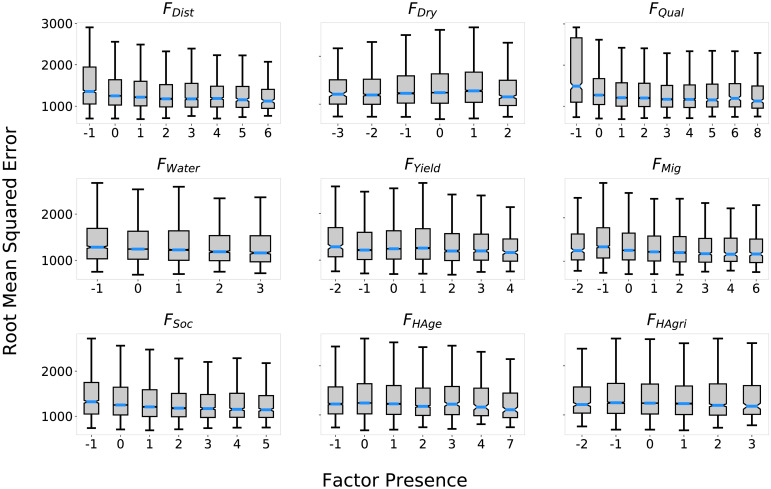
RMSE vs factor presence under SAll.RMSE distributions by factor presence produced by evolutionary model discovery of the farm selection strategy of the Artificial Anasazi under SAll. Only presence values that appeared at least 200 times in the genetic program are displayed. Most factors displayed negative correlations to RMSE, while FDry showed a positive correlation.